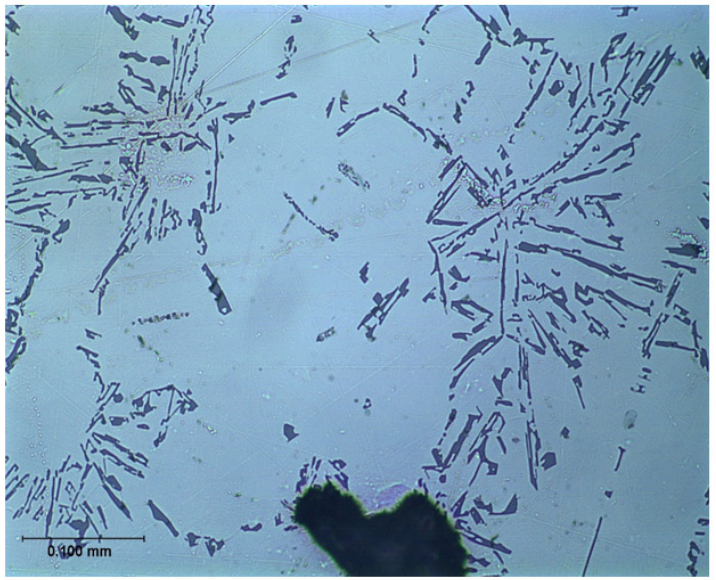
Figure 4. Unmodified Al–7wt.%Si alloy (courtesy Alotech Inc., Cleveland, OH, USA).